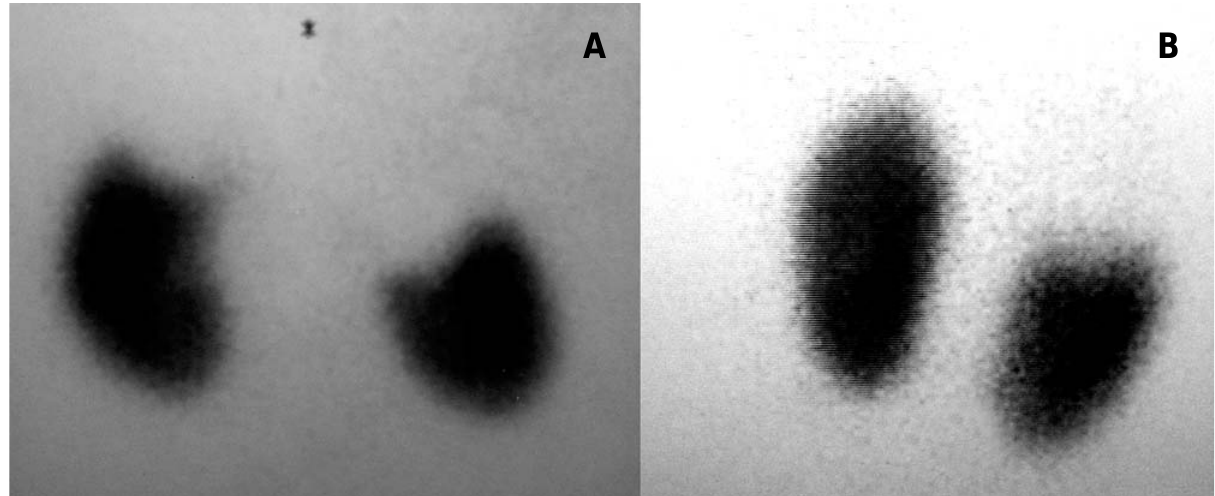
Figure 2 – Selected IMAGES of the 99m Tc-DMSA showing bilateral upper-pole exclusion on the preoperative (A) and parenchymal accommodation on the postoperative period